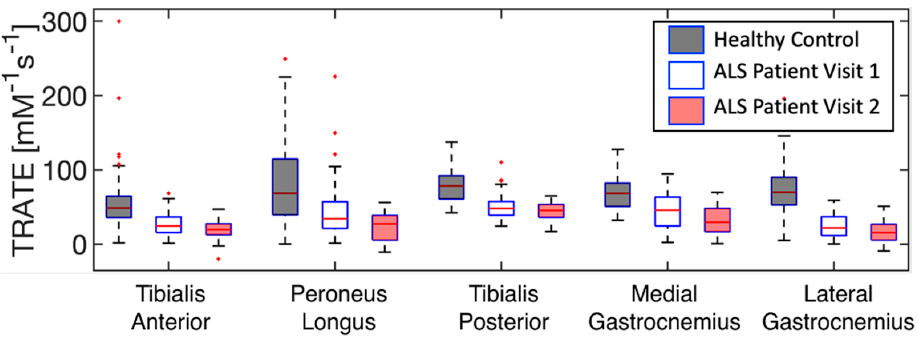
Figure 4. Evolution of TRATE measurements over time in a representative dataset are presented as